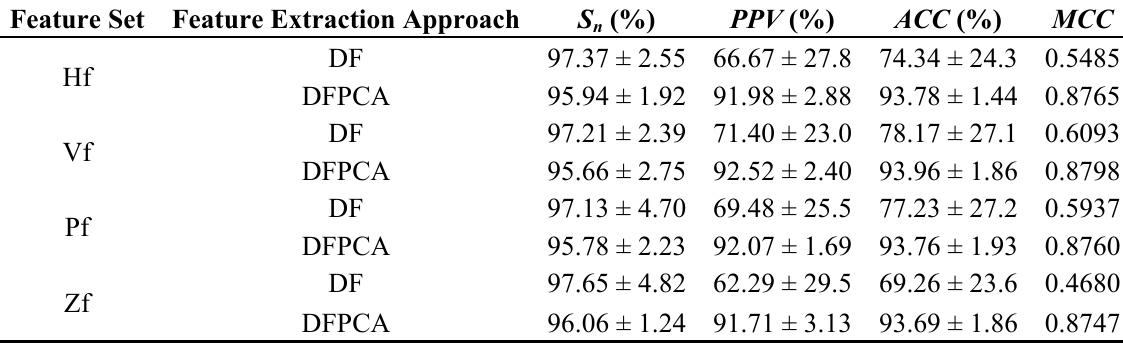
Table 3. Results of DF and DFPCA with PRBF SVM in the 10 CV